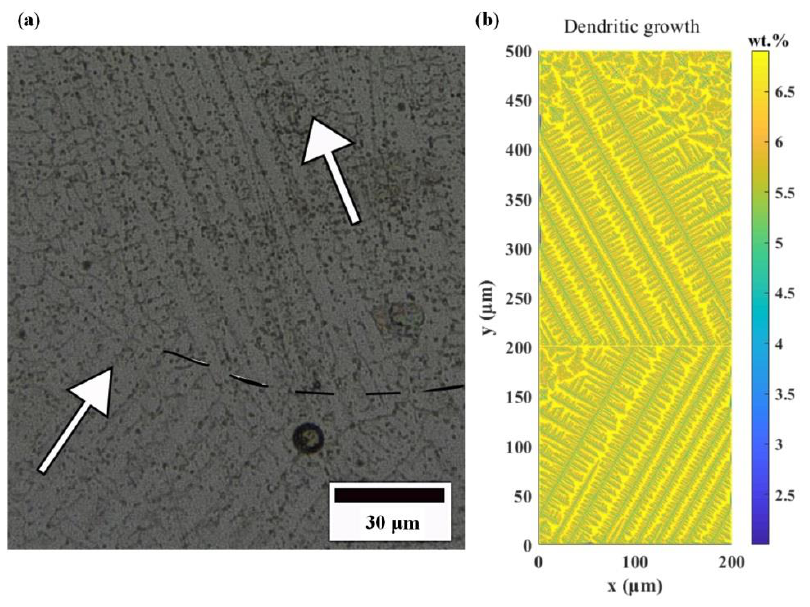
Figure 15. Comparison of dendrites morphology: ( a ) experiment, ( b ) simulation.